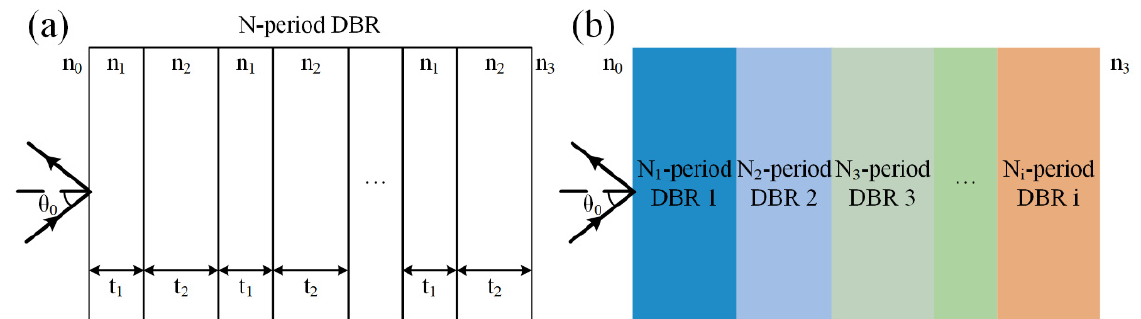
Figure 1. ( a ) Schematic illustration of a single-stack DBR consisting of N periods of layer 1 and layer 2. ( b ) Schematic illustration of DBR consisting of several sub-DBRs. Ni (i = 1, 2, 3…) is the periods of the sub-DBRs.